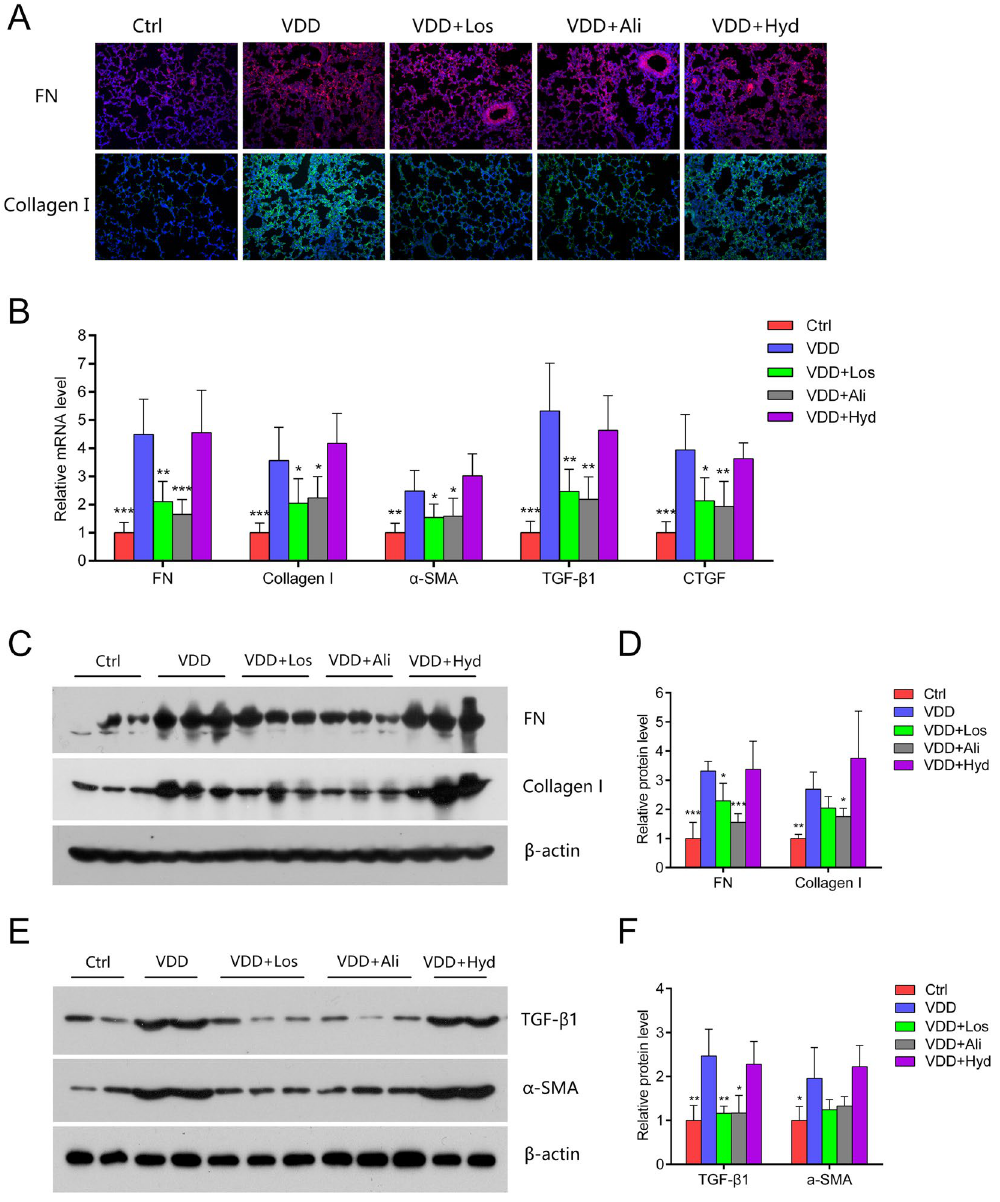
Figure 5. RAS blockers losartan and aliskiren reduce lung ECM deposition, while the vascular relaxant hydralazine does not have this effect. ( A ) Immunofluorescence staining of the lung tissue with fibronectin and collagen I in each group. Original magnification: 200 × . ( B ) Relative mRNA expressions of fibronectin, collagen I, α -SMA, TGF- β 1 and CTGF by real-time PCR. * P < 0.05, ** P < 0.01, *** P < 0.001 compared to the VDD group (n = 5–6 in each group). ( C , D ) Western blotting and protein quantification of fibronectin and collagen I. * P < 0.05, ** P < 0.01, *** P < 0.001 compared to the VDD group (n = 5–6 in each group). ( E , F ) Western blotting and protein quantification of TGF- β 1 and α -SMA. * P < 0.05, ** P < 0.01 compared to the VDD group (n = 5–6 in each group). FN: fibronectin; α -SMA: α -smooth muscle actin; TGF- β 1: transforming growth factor- β 1; CTGF: connective tissue growth factor; Ctrl: control; VDD: chronic vitamin D deficiency; VDD + Los: chronic vitamin D deficiency treated with losartan; VDD + Ali: chronic vitamin D deficiency treated with aliskiren; VDD + Hyd: chronic vitamin D deficiency treated with hydralazine. Statistics: Two-way ANOVA and Dunnett t -test. All electrophoresis was performed under the same conditions, and the gel images were cropped for concise presentation. The uncut images are provided in the Supplementary